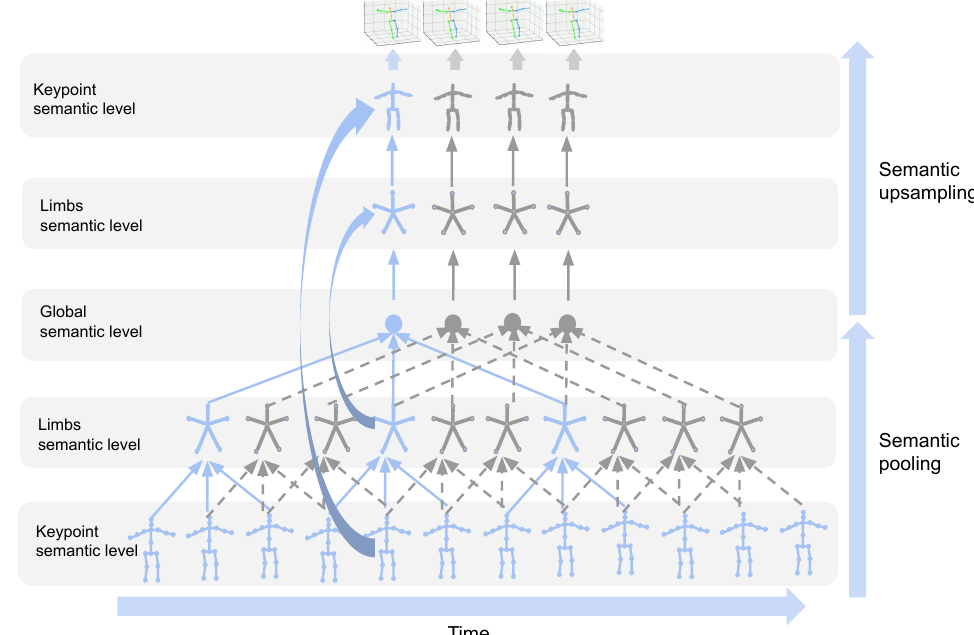
Figure 1. Illustration of the proposed skeleton-based spatio-temporal U-Net. In the semantic pooling stage, spatio-temporal semantic features are gradually compressed and fused into different granulari- ties. In the semantic upsampling phase, spatio-temporal features are decoded and multi-resolution spatio-temporal dependencies are abstracted by skipping connections in the U-Net